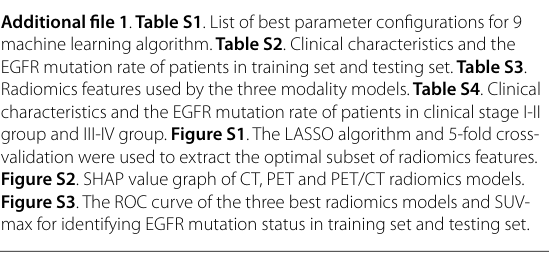
Figure S3 . The ROC curve of the three best radiomics models and SUV- max for identifying EGFR mutation status in training set and testing set. Acknowledgements Not